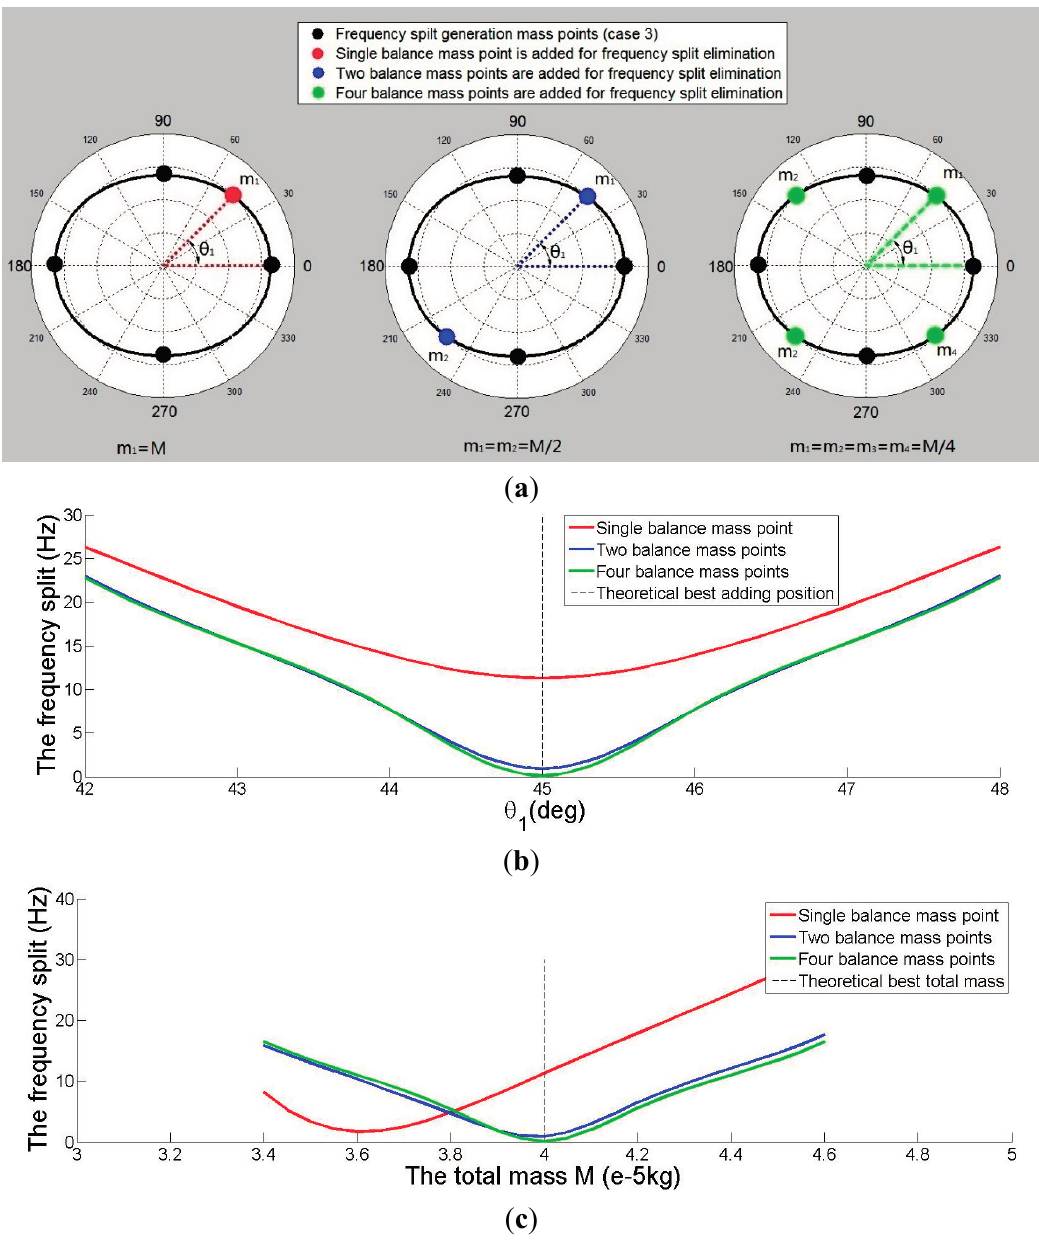
Figure 9. ( a ) The distribution of added mass points for eliminating frequency split Case 3; ( b ) The relationship between θ 1 and frequency split for eliminating frequency split Case 3 ( M = 0.04 g); ( c ) The relationship between mass of balance points M and frequency split for eliminating frequency split Case 3 ( θ 1 = π